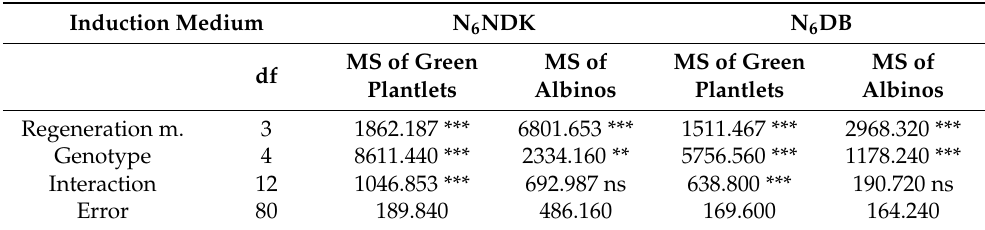
Table 3. Statistical analyses (two-way ANOVA) of plant regeneration efficiency (number of green- and albino plantlets) using different induction media.